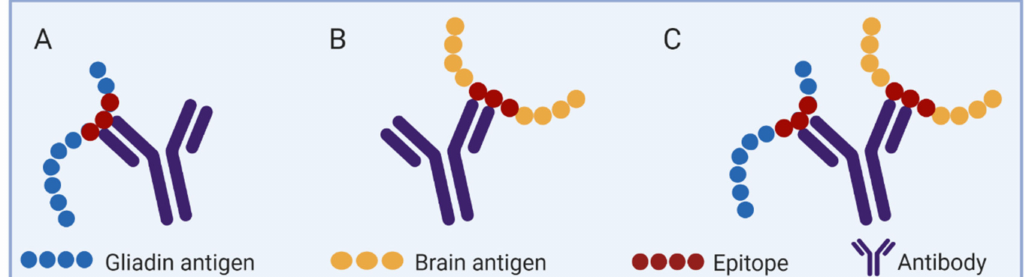
Figure 1. A schematic presentation of cross-reactive antibodies between two separated antigenic determinants. The specific antibody that reacted with each is cross-reacting to both of them. ( A ) Anti-gluten/gliadin antibodies. ( B ) Anti-brain autoantibodies. ( C ) Anti-gluten/gliadin and brain epitopes cross-reactive